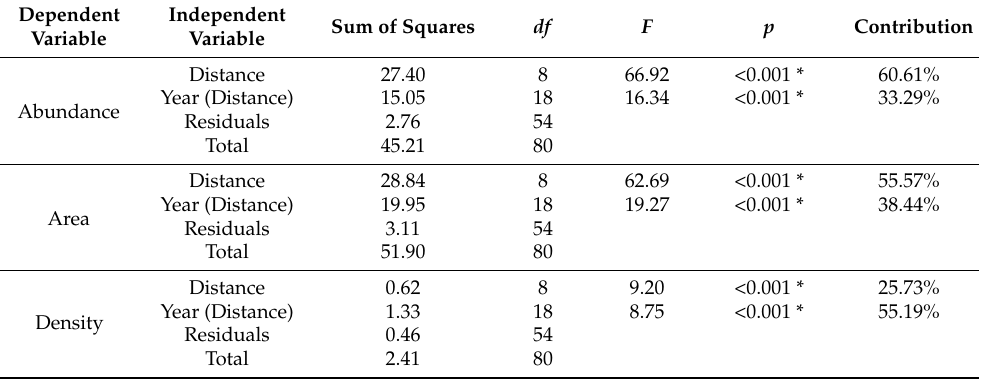
Figure 5. Penguin abundance ( a ), colony area ( b ) and density ( c ) at different distances from the shoreline. Histograms represent the total value and the lines are the relative proportion. Table 4. Summary results of nested ANOVA analyses for determining the contribution of distance and year to penguin abundance, colony area and density between different distance ranges in study years. Year (Distance) represents year nested in distance in nested ANOVA analyses. * p < 0.01 according to nested ANOVA.